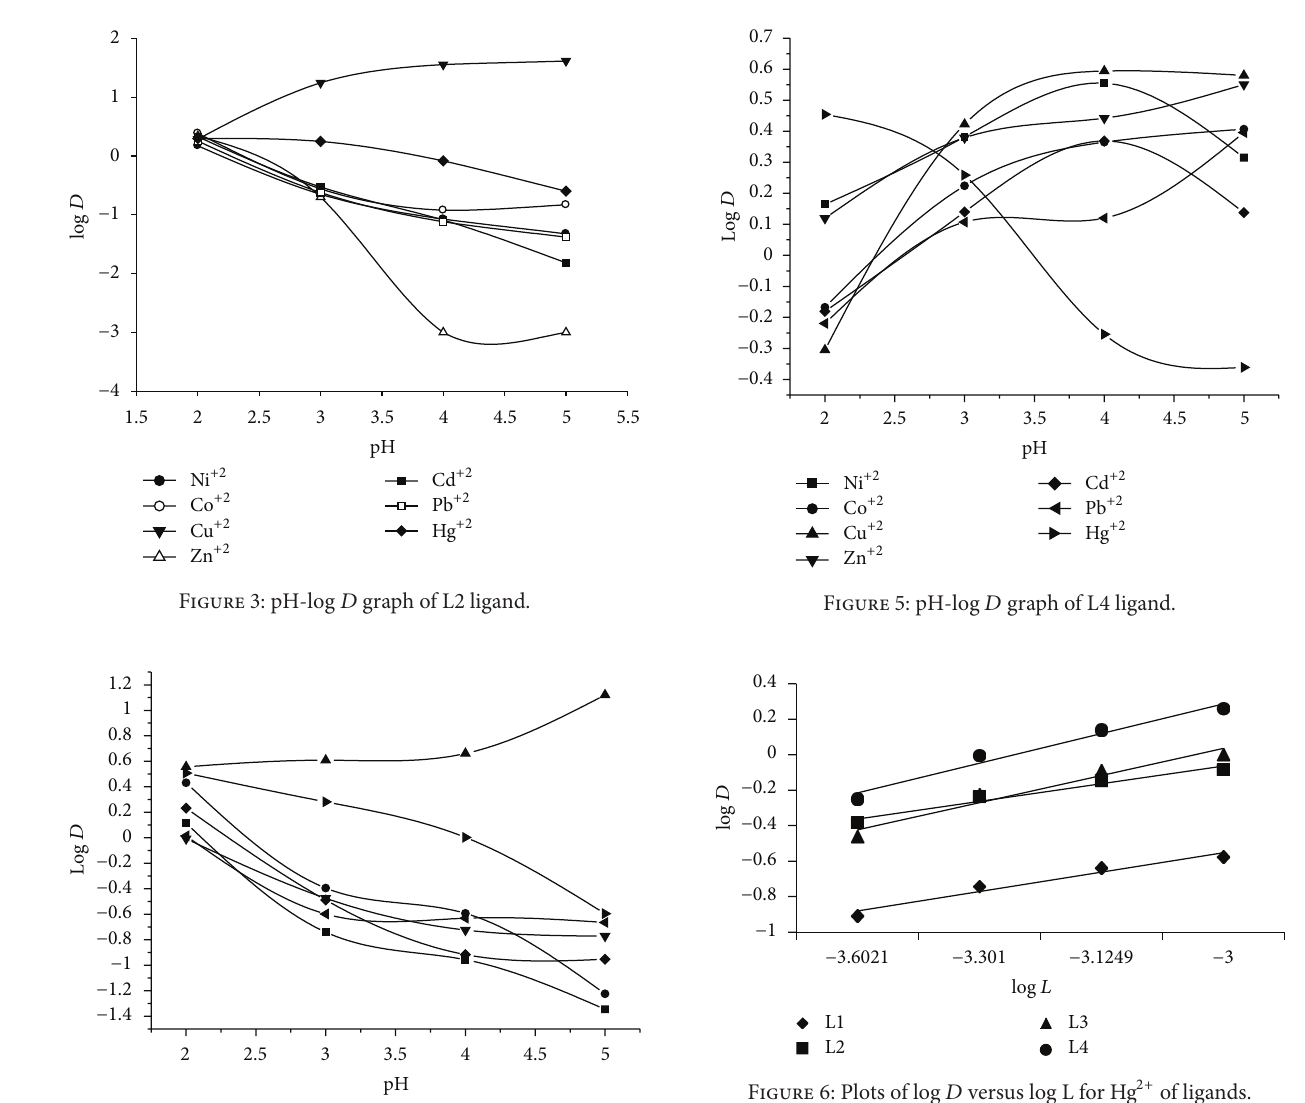
Figure 6: Plots of log 𝐷 versus log L for Hg 2+ of